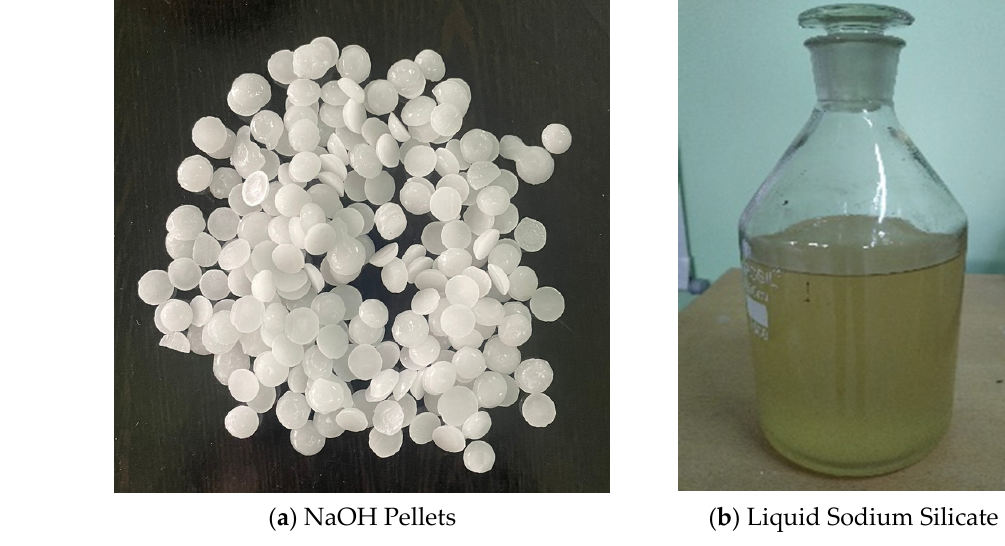
Figure 3. Common alkali activators used in